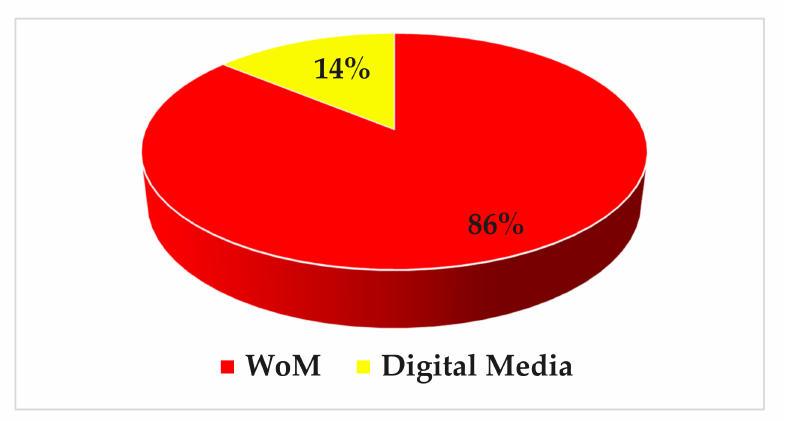
Figure 2. Source of information. WoM,